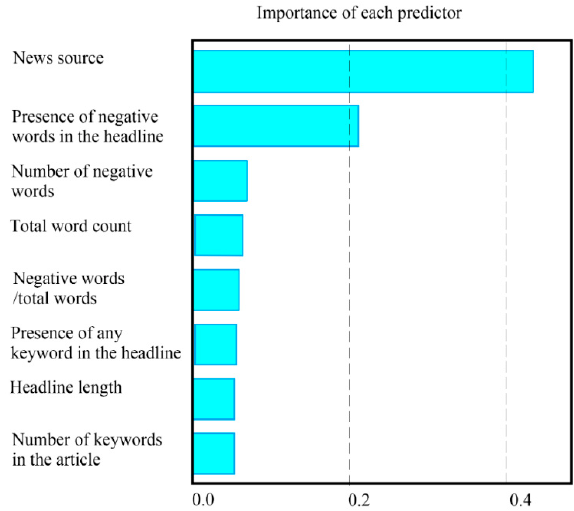
Figure 12. Support vector machine (SVM) analysis of the importance of each variable for abnormal returns.